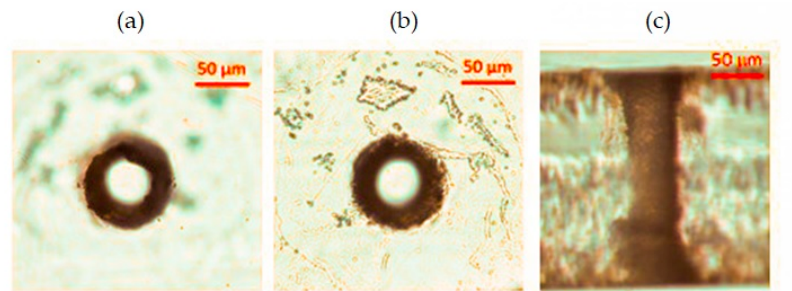
Figure 8. Optical microscope images of a through hole generated in a 200 μ m-thick AF32 glass, in water assisted micromachining configuration, with writing trajectories starting from the aperture external contour towards its center, allowing for considerably reducing the fabrication time. Top ( a ), bottom ( b ) and lateral view ( c ).